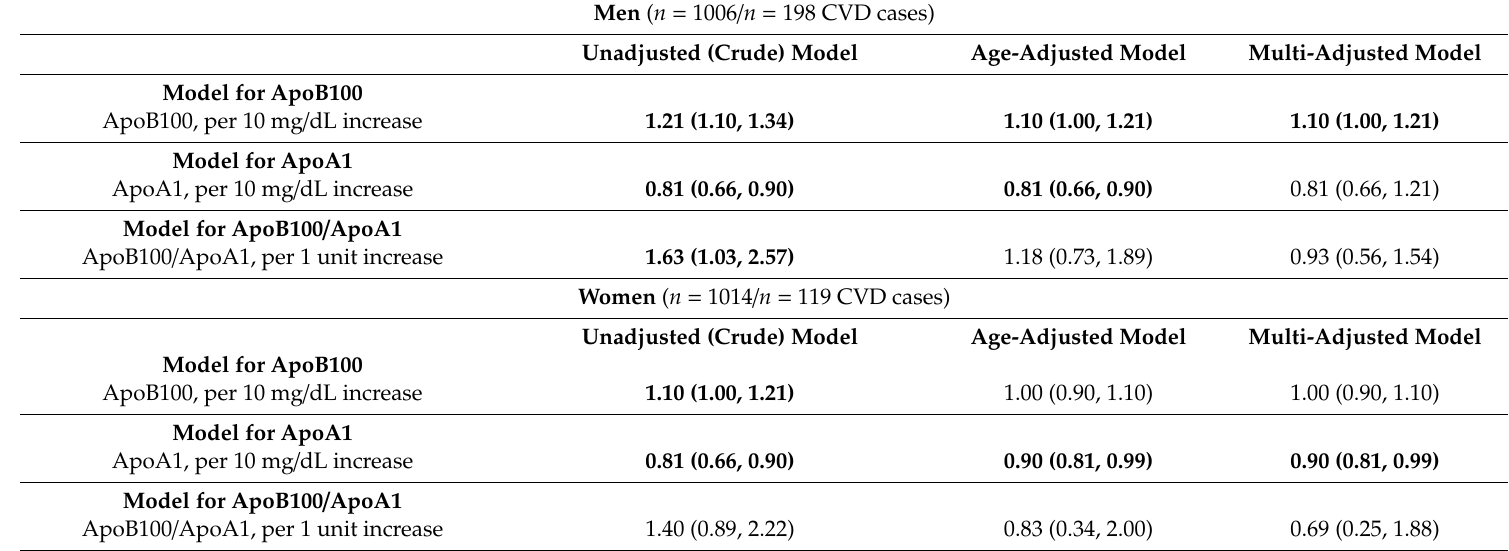
Table 3. Cox regression analysis to evaluate the association between apolipoproteins and 10-year first fatal / non fatal cardiovascular disease incidence in apparently healthy men and women ( n =